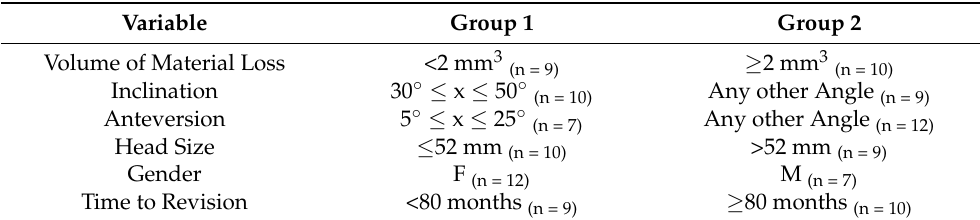
Table 1. Criteria used to subdivide the population of BHR acetabular surfaces for comparison. The total sample size including in the final model was 19, following the exclusion of the outlier high wearing example.